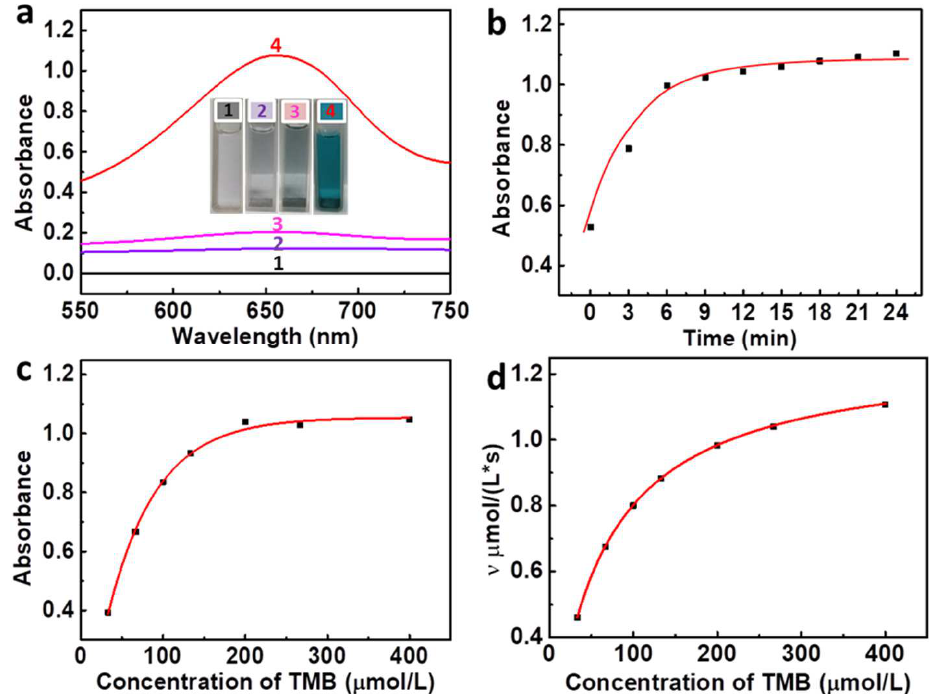
Figure 3. ( a ) Reaction between Co 3 O 4 and TMB (curve 1-TMB + buffer, curve 2-TMB + buffer + Co 3 O 4 - 800, curve 3-TMB + buffer + Co 3 O 4 -500, curve 4-TMB + buffer + Co 3 O 4 -200), ( b ) the absorbance change of TMB in the presence of Co 3 O 4 -200 over the time at 40 °C, ( c ) the absorbance change for different concentrations of TMB, and ( d ) the Michaelis–Menten curve of Co 3 O 4 -200 with TMB.